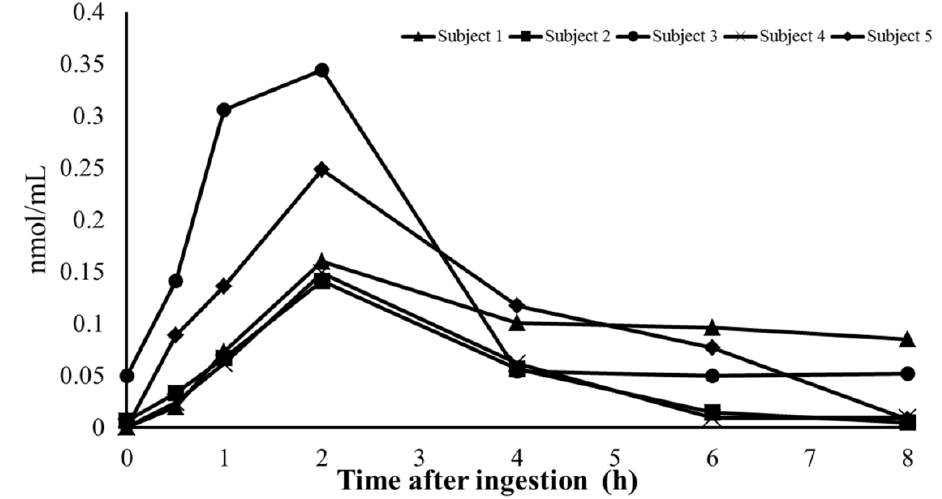
Figure 5. Changes in the concentration of cyclic Pro-Hyp in human plasma of five volunteers. Nutrients 2018 , 10 , x FOR PEER REVIEW